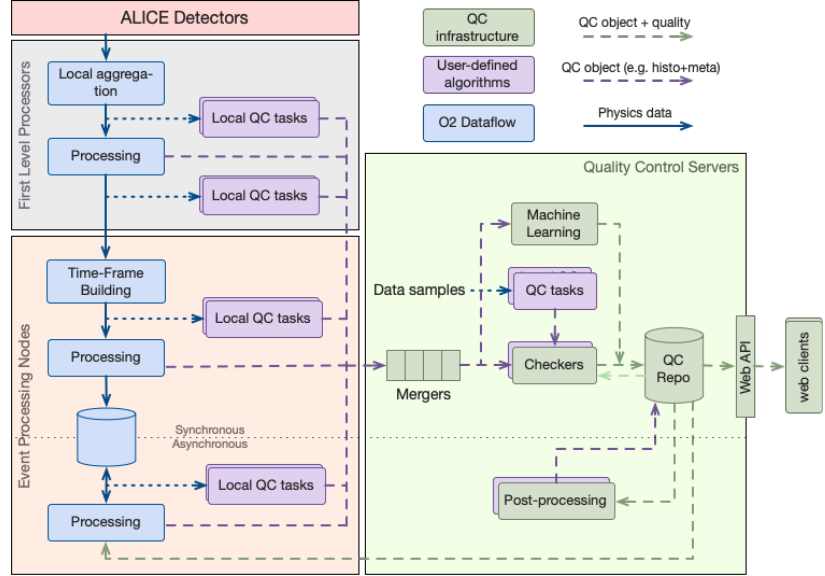
Figure 1. The QC